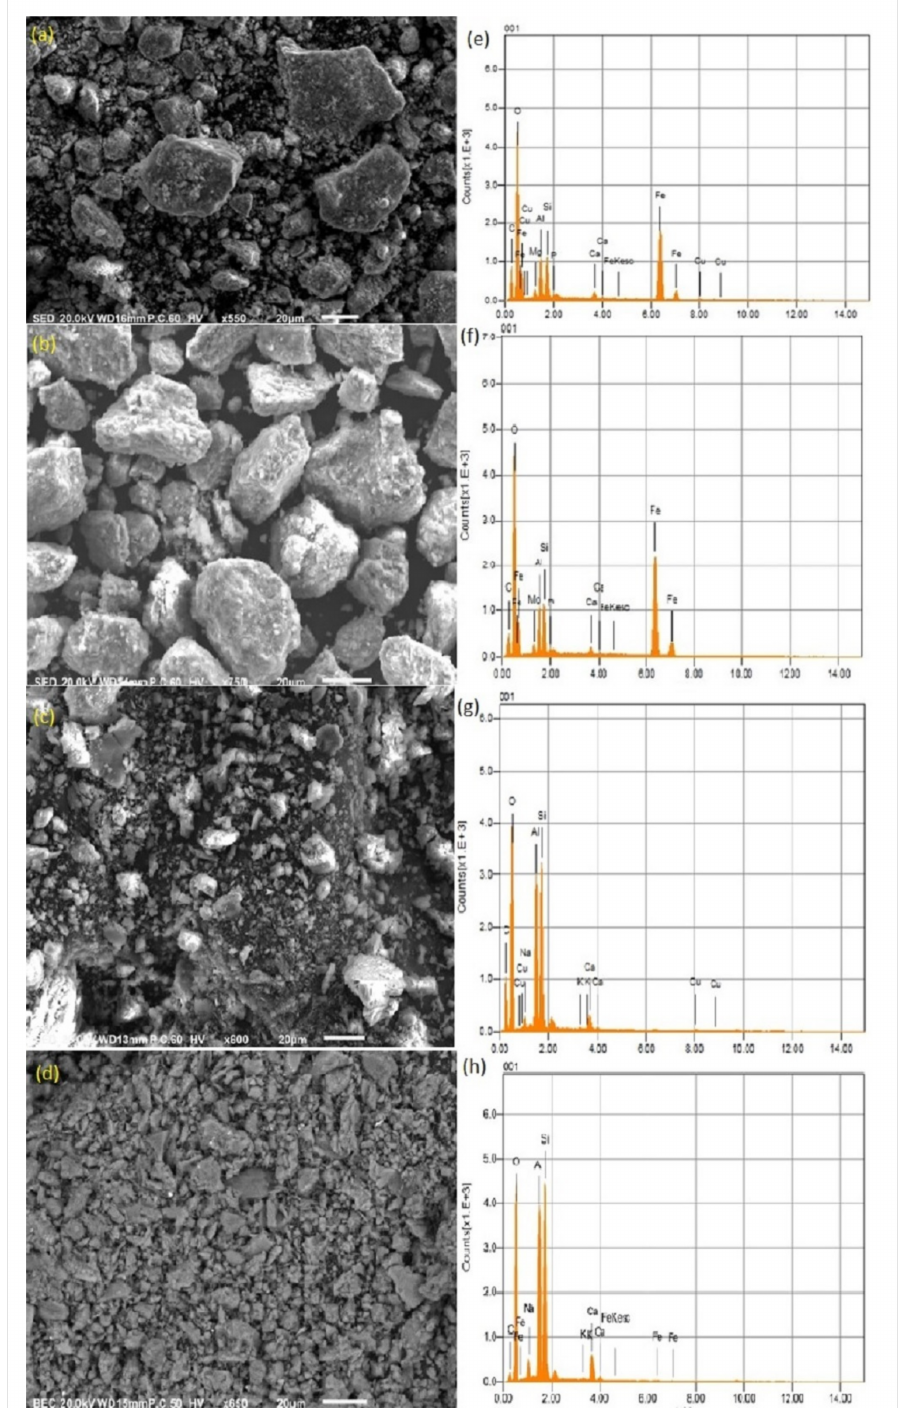
Figure 6. SEM micrographs along with EDX plots of a selected laterite ( a , b , e , f ) and kaolinite ( c , d , g , h ) samples taken before and after